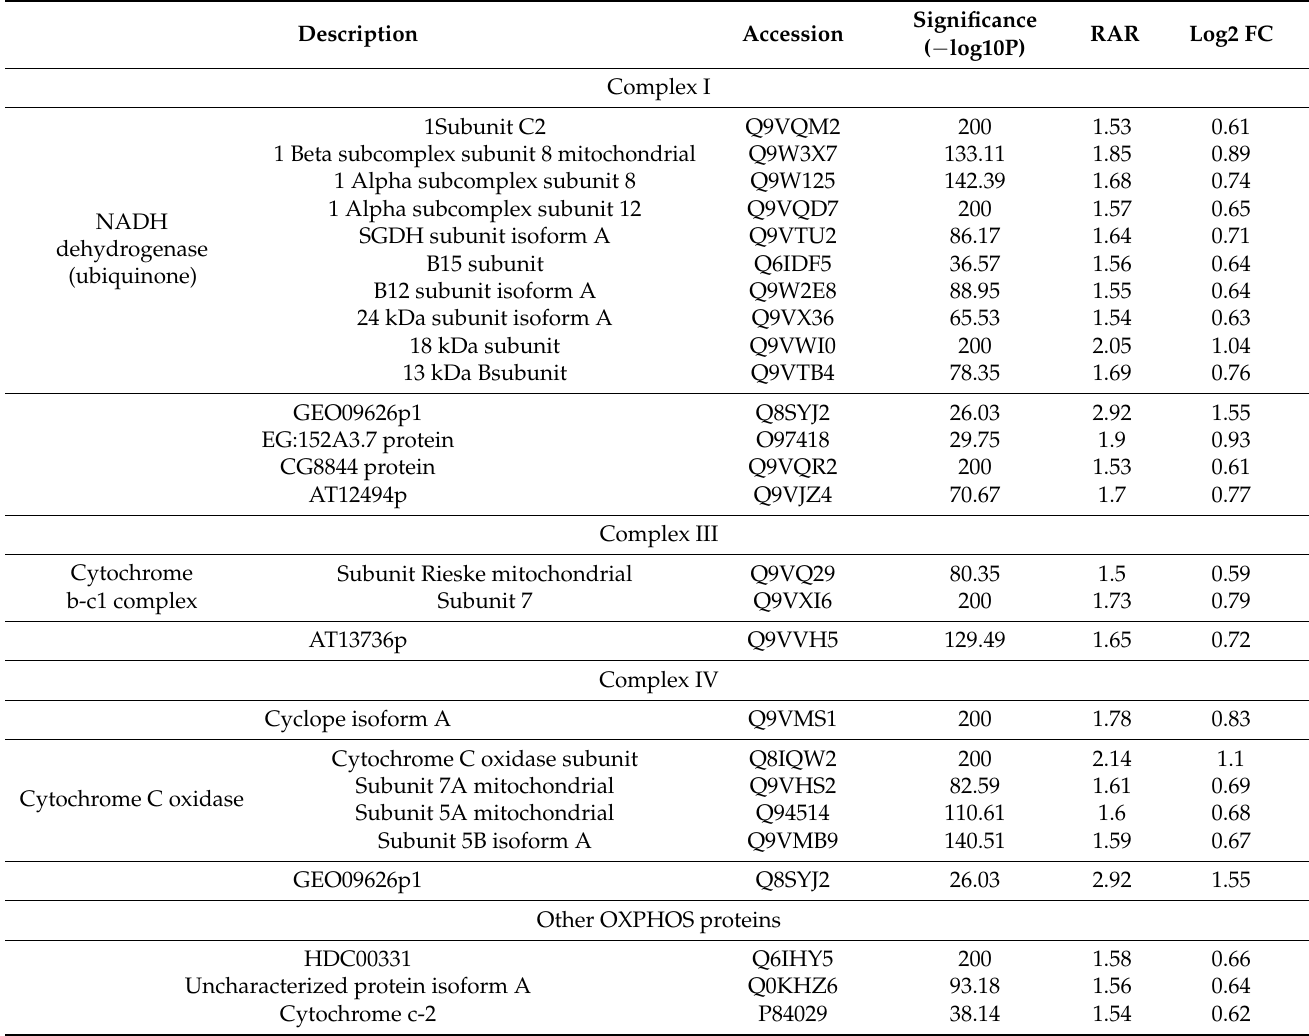
Table 2. Electron transport chain proteins increased in abundance in response to one week of exercise in D. melanogaster ( n = 3). Enrichment analysis used Gene Ontology cellular component allocation from STRING database v.11.0. RAR: relative abundance ratio; FC: fold